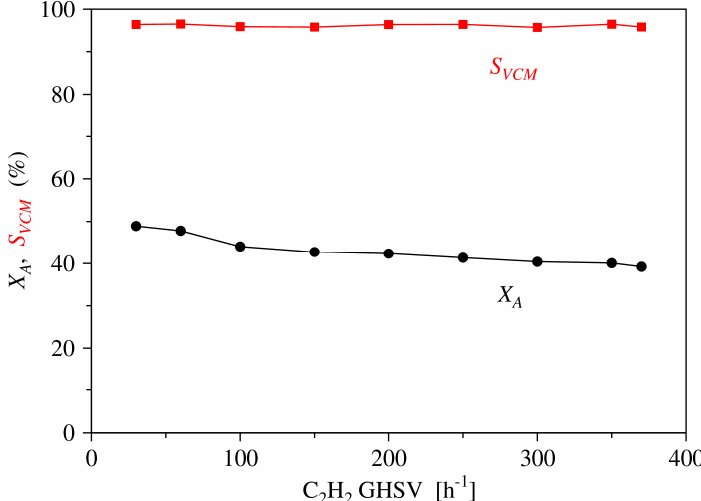
Figure 8. Acetylene conversion rate and VCM selectivity of CuCl 2 -[PrMIm]Cl, as a function of C 2 H 2 GHSV. Reaction conditions: temperature 140 °C, CuCl 2 concentration 0.065 mol L − 1 , V HCl :V C2H2 = 1.2.